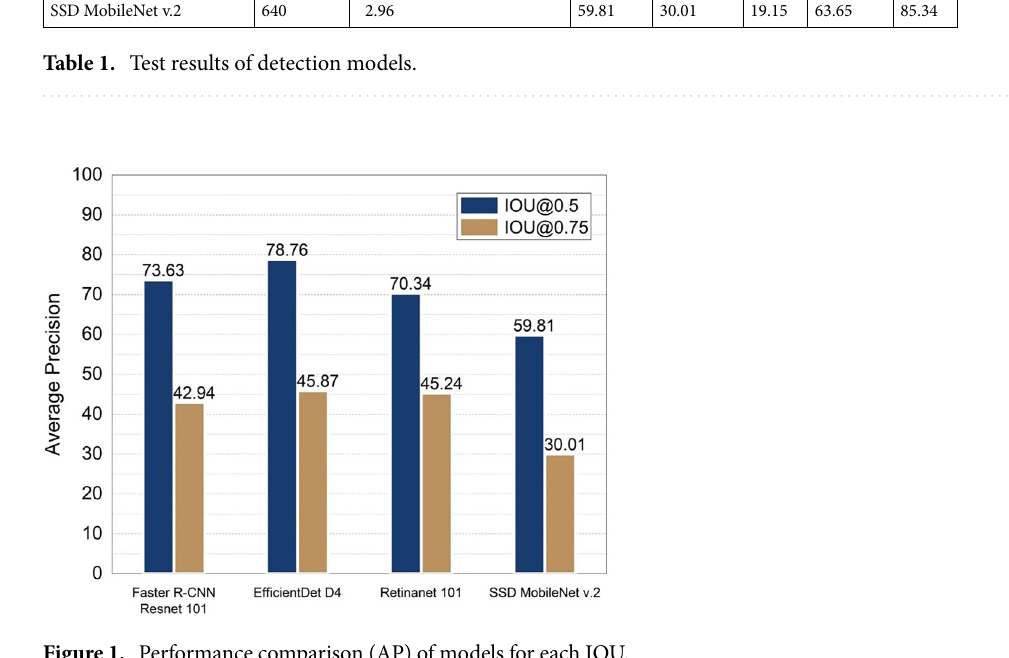
Figure 1. Performance comparison (AP) of models for each